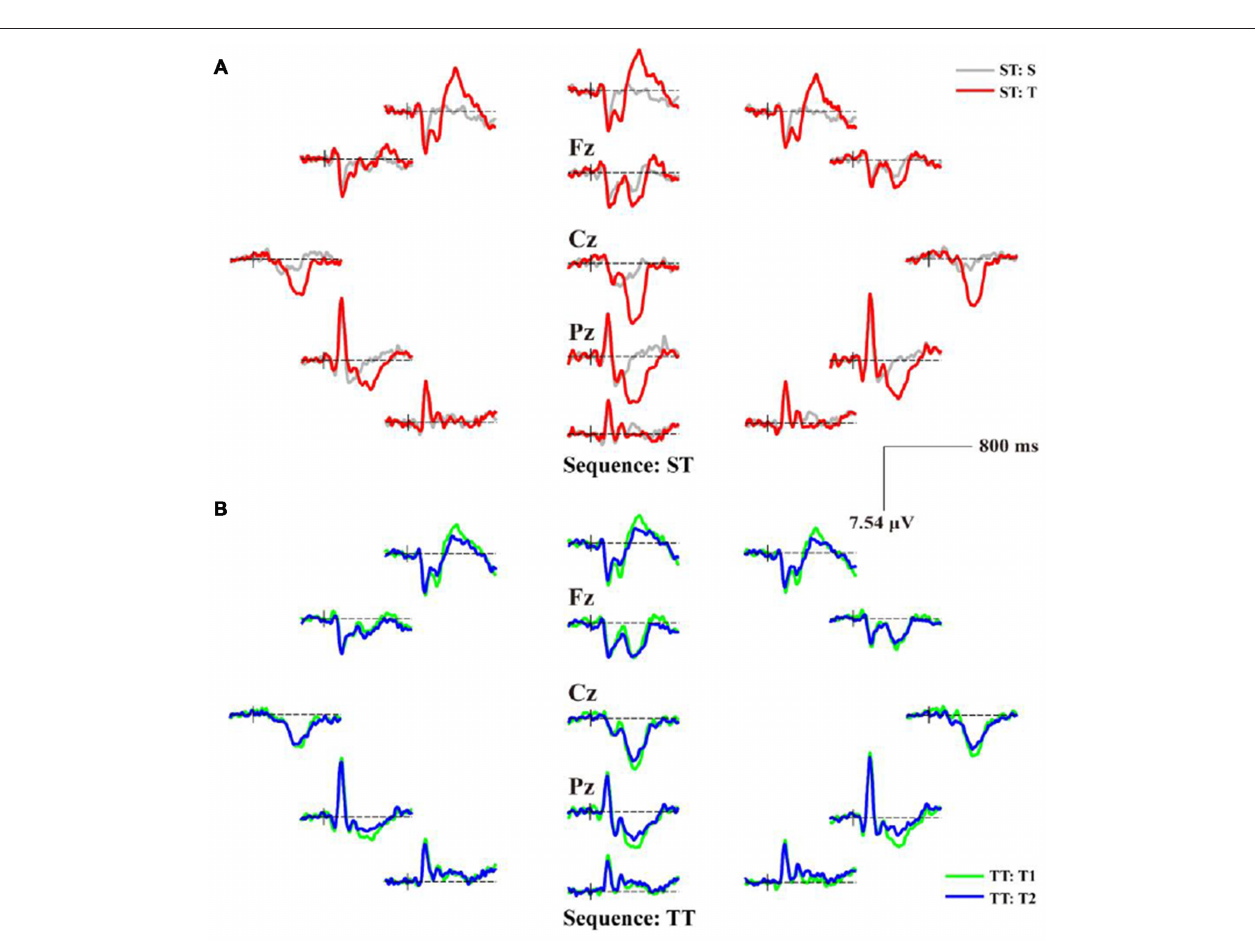
FIGURE 3 | The scalp distributions of averaged P300 event-related potentials (ERPs) for ST and TT sequences during P300 task. (A) P300 ERPs of ST. (B) P300 ERPs of TT. In (A) , the gray and red solid lines denote the waveforms evoked by the S and T stimulus, respectively. In (B) , T1 and T2 denote the first and second T stimulus in TT sequence, respectively; and the green and blue solid lines denote the waveforms evoked by the T1 and T2 stimulus, respectively.